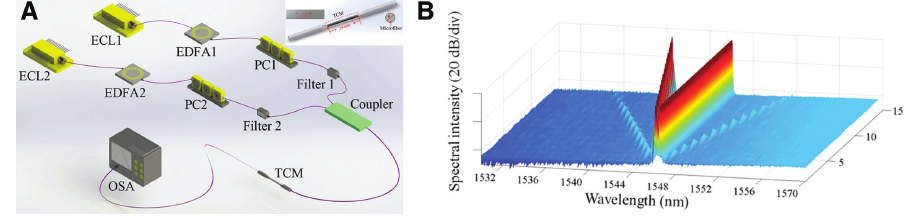
Figure 22: FWM wavelength conversion based on a TI-coated microfiber. (A) Experimental setup. (B) Output FWM spectra against wavelength detuning. Reproduced with permission [281]. Copyright 2015 John Wiley and Sons.